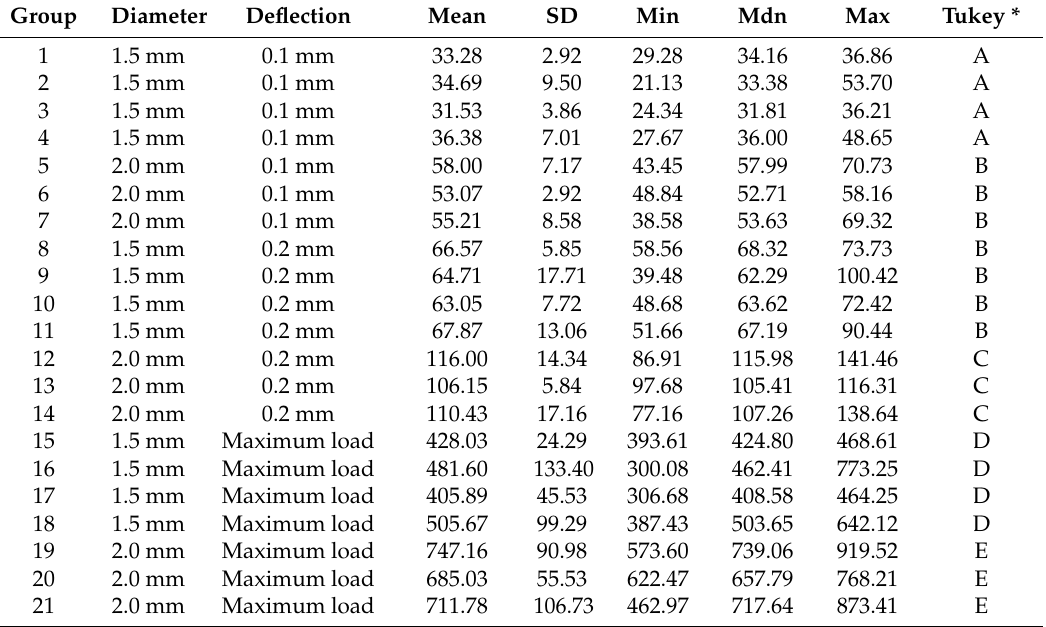
Table 2. Descriptive statistics of maximum force values (N) of the 21 groups tested ( each group consisted of 10 specimens).